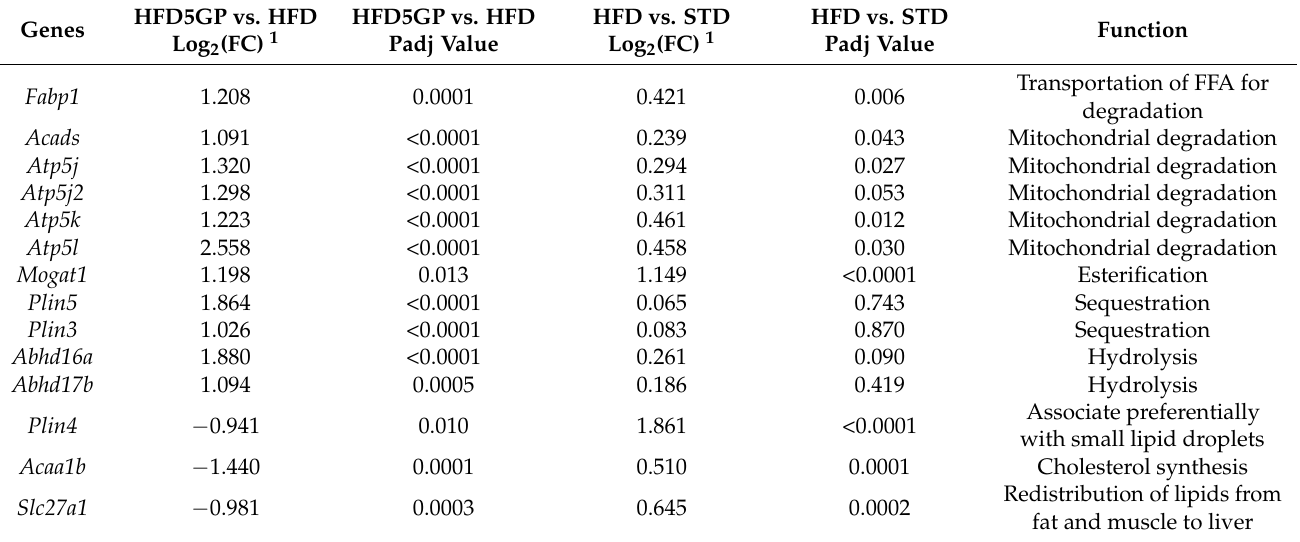
Table 3. Mouse hepatic genes involved in lipid metabolism that are modulated by grape powder supplementation of the